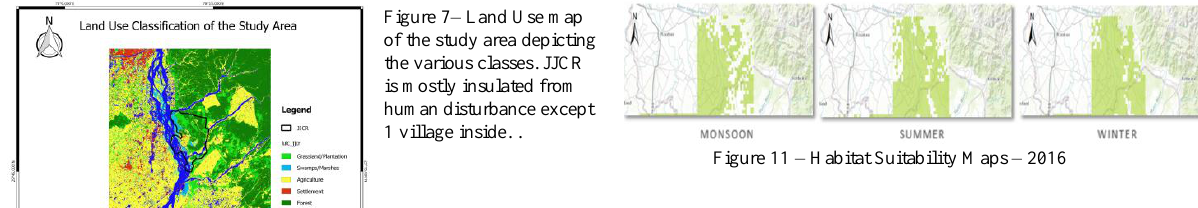
Figure 10 - Contributions of variables for various seasons A- Monsoon 2016, B - Summer 2016 & C-Winter 2016